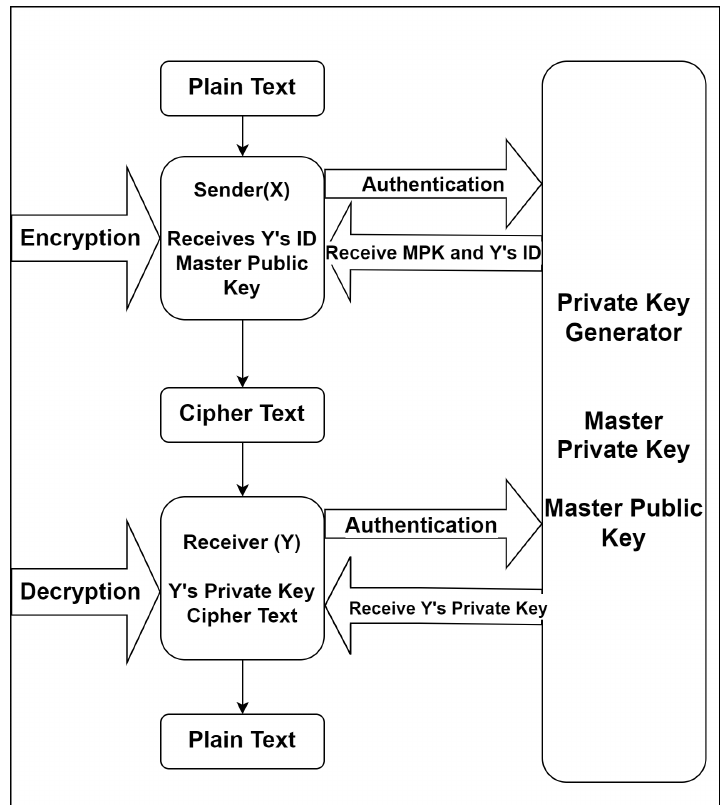
Figure 3. Working Model of Identity-Based Encryption (IBE).